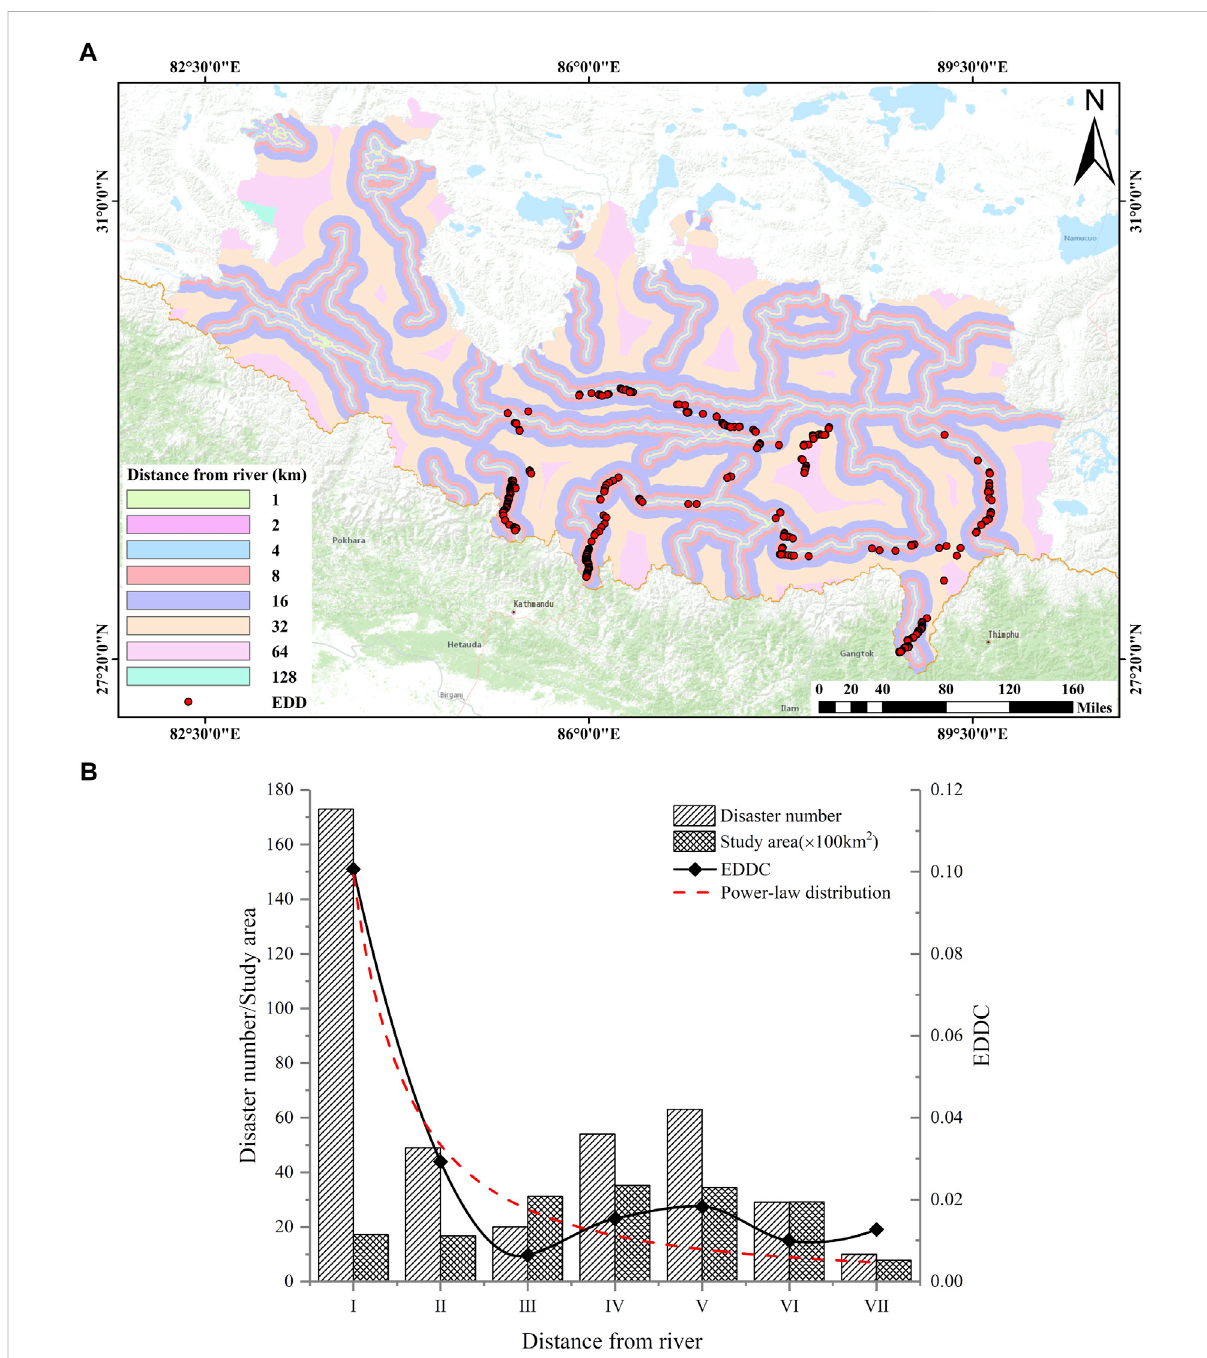
FIGURE 12 (A) Distance from river map of the study area; (B) Relationship between engineering disturbance disaster distribution and distance from